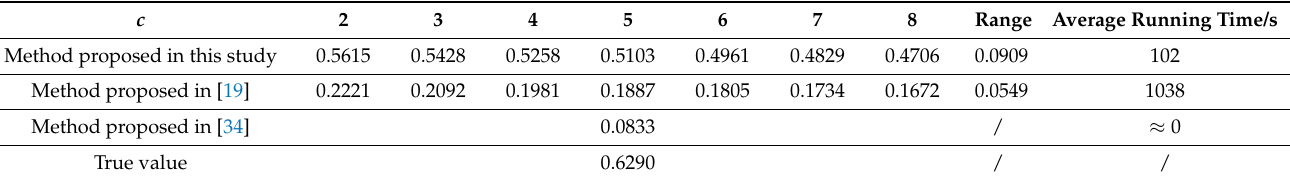
Table 2. The failure probability p i at c .